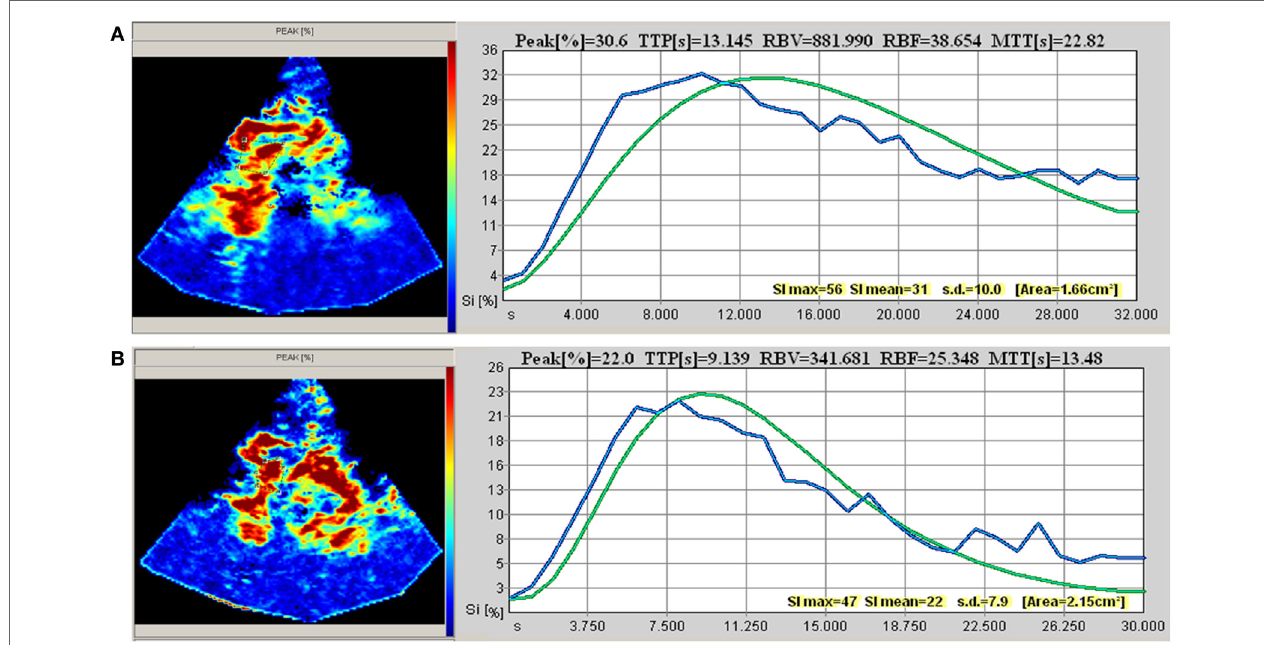
FigUre 2 | Transcranial perfusion sonography (example taken from patient 2). (a) Baseline measurement [before optimization of cardiac index (CI)] at CI 2.1 and mean arterial pressure (MAP) 89 mmHg. (B) Second measurement (after optimization of CI) at CI 3.45 and MAP 89